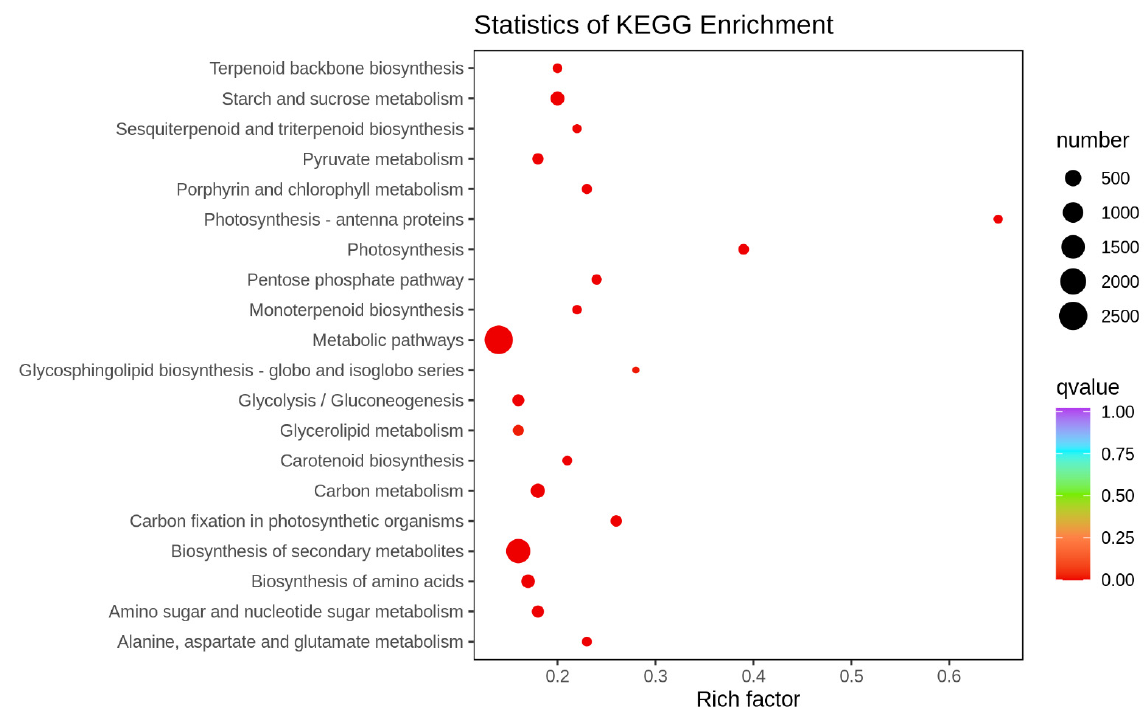
Figure 4. Top 50 enriched GO pathways in a comparison of CG and DS transcriptomes.